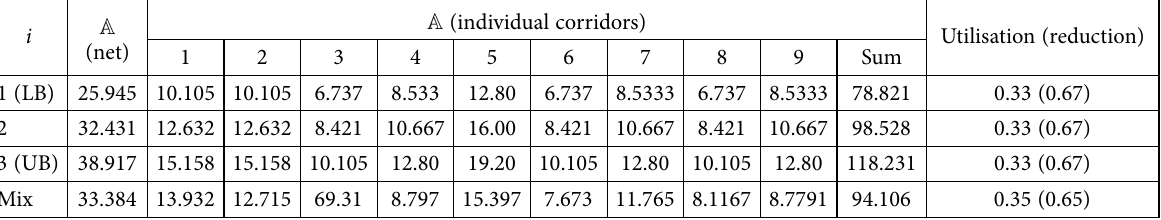
Table 7. Sensitivity analysis of further duplicated bottleneck sections